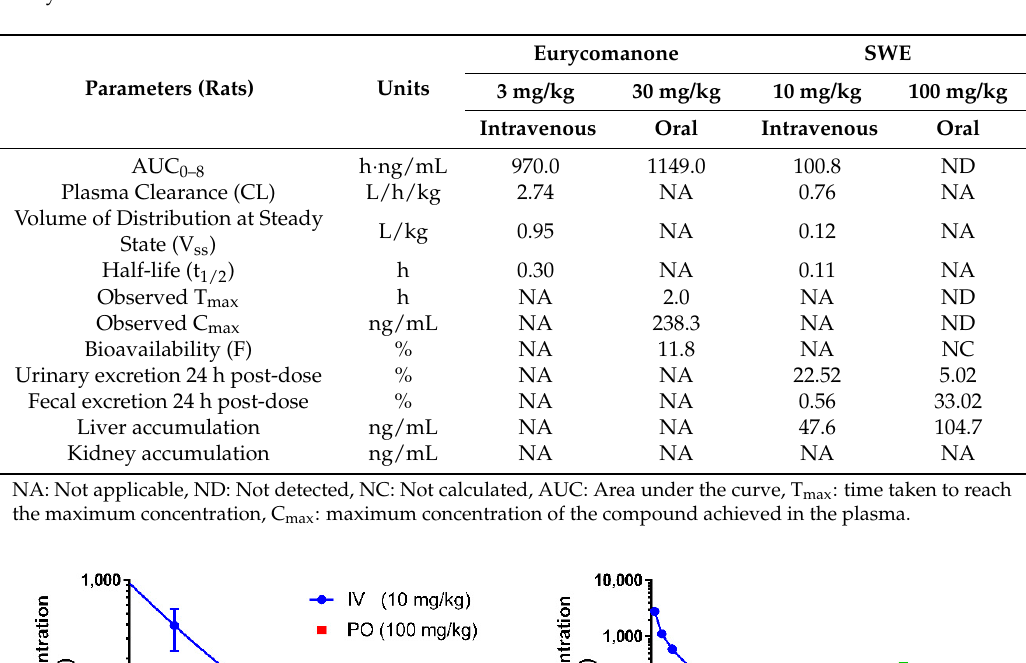
Table 2. Summary of pharmacokinetic parameters following an intravenous and oral dose of eurycomanone and SWE to rats.